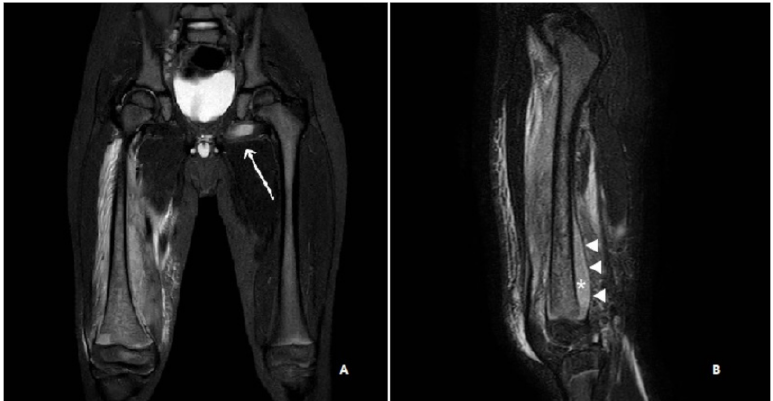
Figure 1. Coronal ( A ) and sagittal ( B ) STIR (short tau inversion recovery) MR images show ab- normal bone marrow oedema in the distal femur, with marked irregularity of the signal intensity and an associated large subperiosteal abscess (*) due to accumulation of pus beneath the elevated periosteum (arrowheads). Fasciitis and pyomyositis of the right thigh as well as an abscess in the contralateral obturator externus muscle (arrow) are also